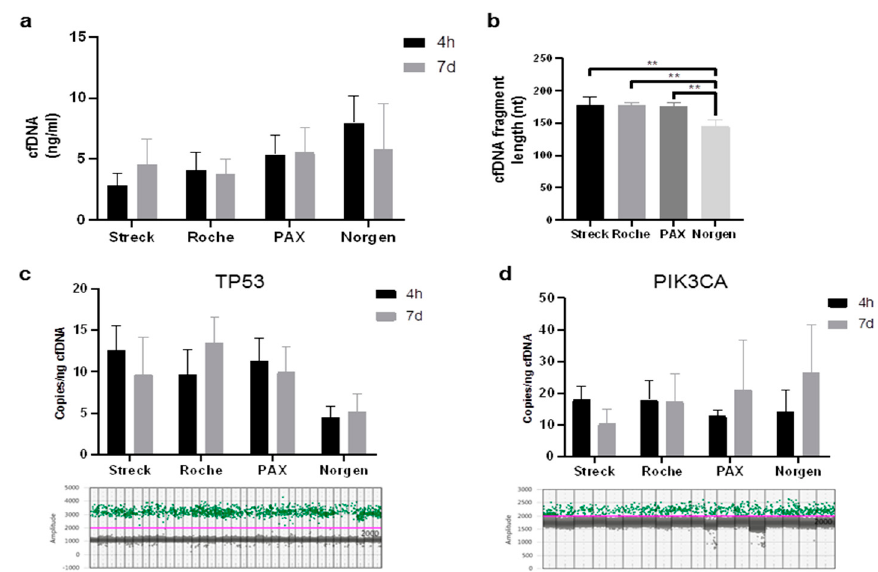
Figure 3. Stability of cfDNA stored in long-term storage tubes. Quantification of cfDNA in plasma after storing blood for 4 h or 7 days in Streck, Roche, PAX, and Norgen tubes ( a ). Representative DNA fragment analysis from each tube type ( b ). Quantification of TP53 copies per ng cfDNA input; representative 1D scatterplots of TP53 detection by droplet digital PCR (ddPCR) are depicted ( c ). Quantification of PIK3CA copies per ng cfDNA input; representative 1D scatterplots of PIK3CA detection by ddPCR are depicted ( d ). Grey: negative droplets, green: wild-type copies. Stars represent level of significance with (**) for p -value < 0.01.